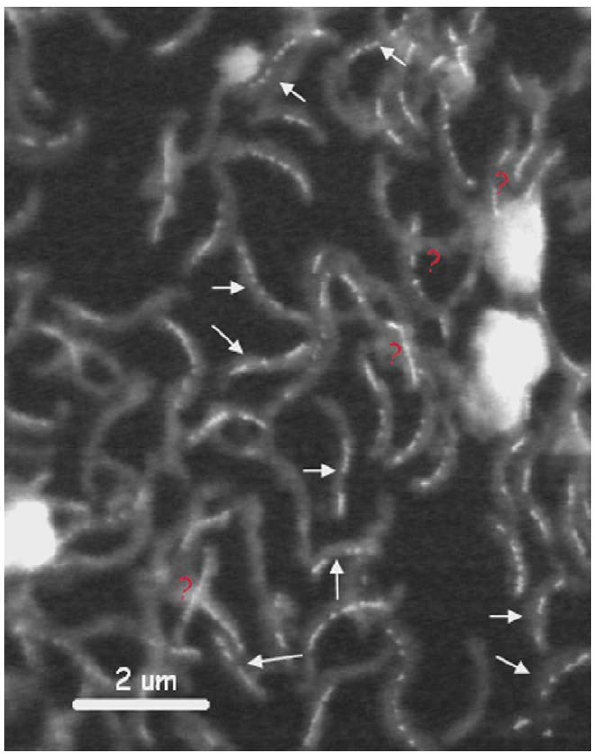
Figure 1. STXM image of an ensemble of cells of Magnetovibrio blakemorei strain MV-1 deposited on a formvar coated 3 mm transmission electron microscopy (TEM) Cu grid. The image was recorded at 709.8 eV and converted to optical density (OD) using the intensity in areas without cells in this image. The arrows indicate cells with apparent gaps in their magnetosome chains. The question marks (red) indicate (multiple) cells that were discounted because of uncertainty as to the number of cells and/or magnetosome chains present.